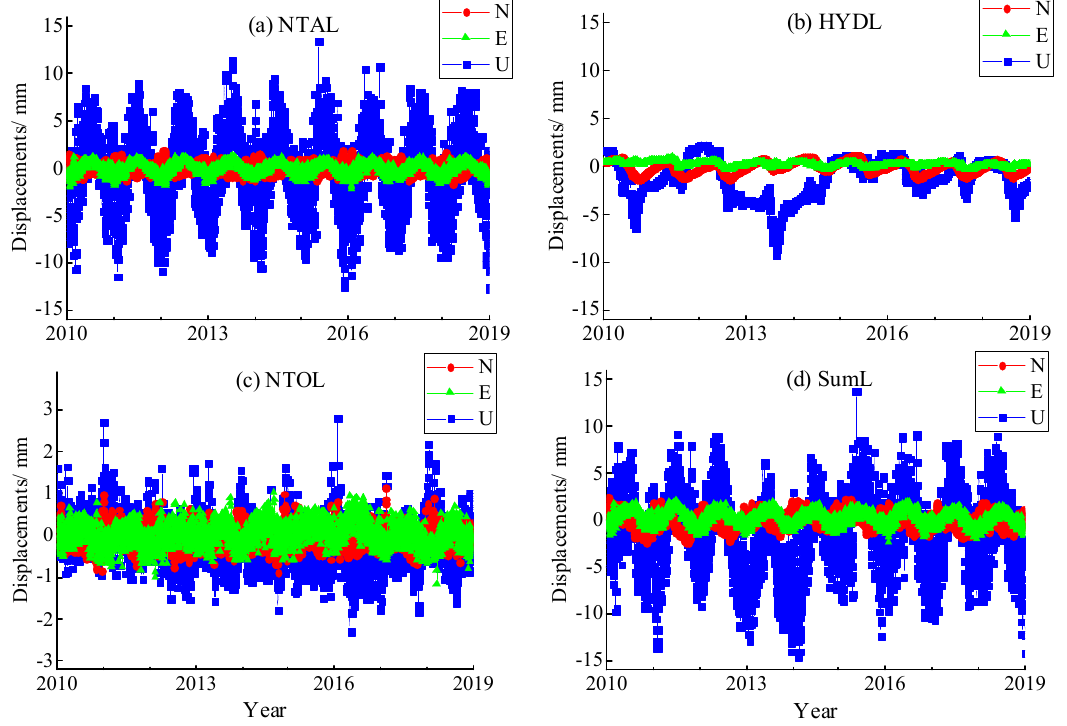
Figure 9. Displacements on CHAN station caused by geophysical signals, including atmospheric loading (NTAL), hydrological loading (HYDL), non-tidal oceanic loading (NTOL) and their sum (SUML). Note that the scale of the vertical axis in (c) is smaller than (a), (b) and (d.) The displacements caused by environmental loadings in vertical component (Up) are much bigger than that in horizontal components (North and East). Among these three loadings, NTAL contributes the most to SUML; the second contributor is HYDL; and NTOL contributes the least to SUML. SUML represents obvious seasonal variations, and its amplitude can be up to 10mm in some years.